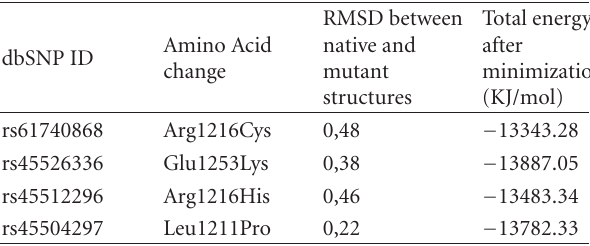
Table 3: RMSD and total energy of native structure (2jo9) and mutant modeled structures. dbSNP ID